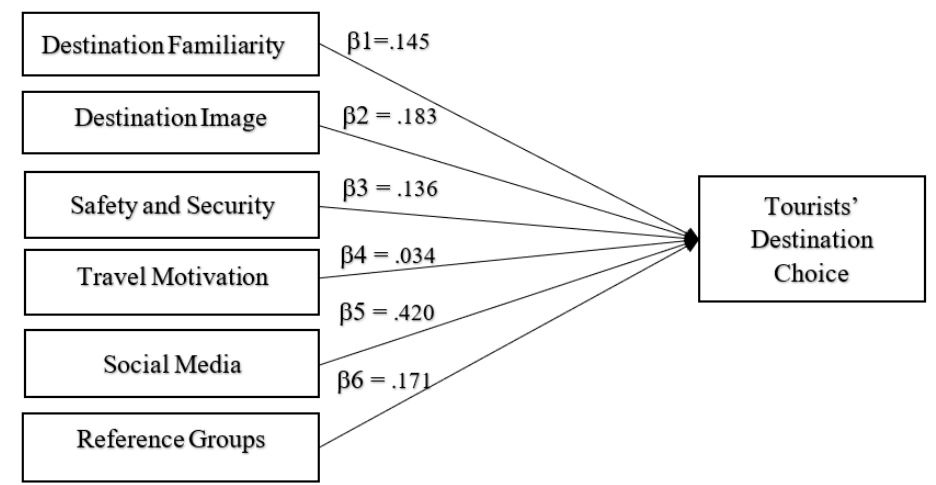
Figure 2. The results of the full